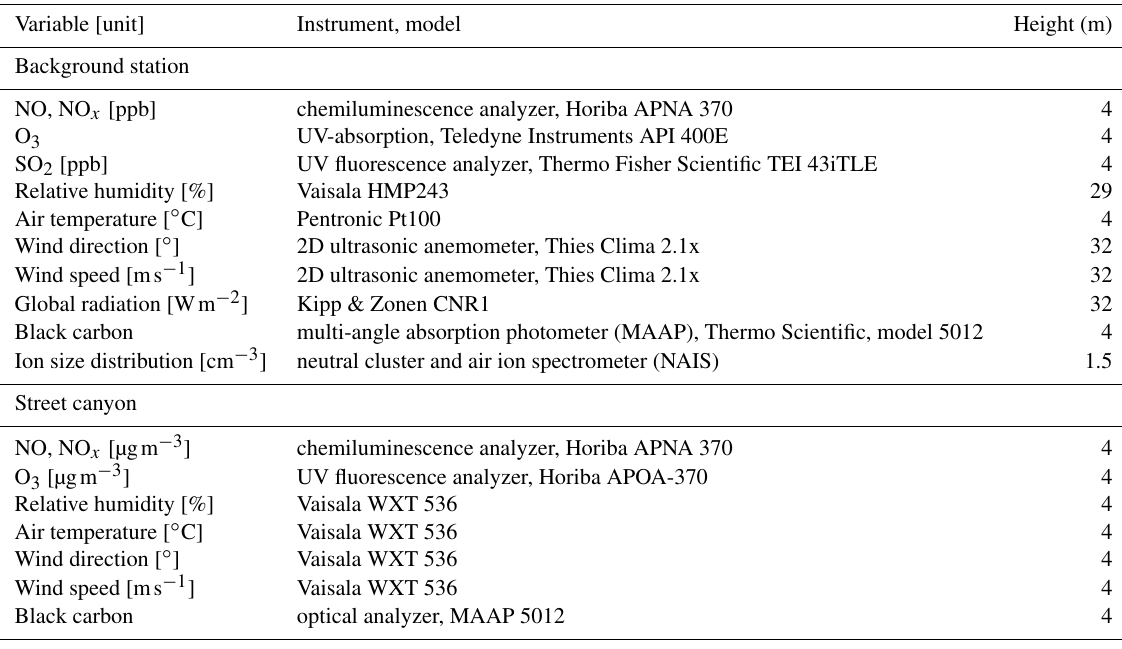
Table A2. Overview of additional variables used in this study measured at the background station and the street canyon